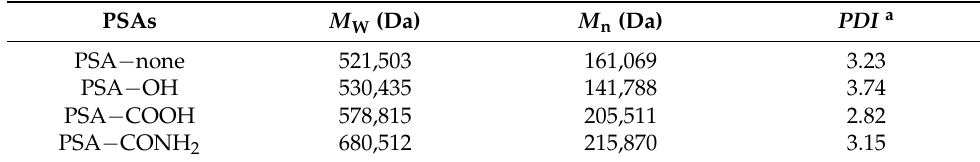
Table 2. Physicochemical parameters of synthesized PSAs.